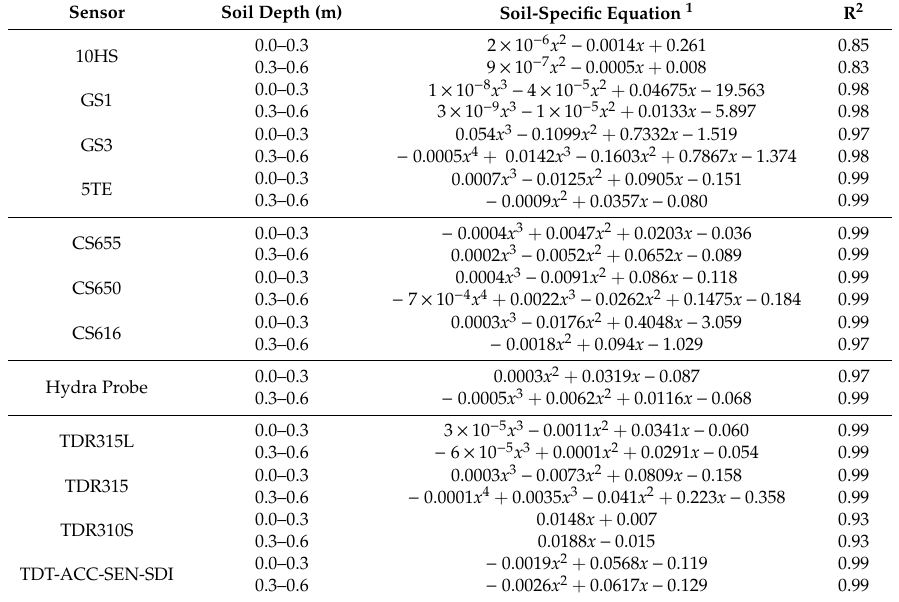
1 Variable corresponds to the response value of the sensor (voltage, period, or dielectric constant). The obtained result from each equation is the soil volumetric water content ( θ v ). Measuring technique: Frequency Domain Reflectometry—FDR (10HS, GS1, GS3, and 5TE); Transmission Line Oscillation—TLO (CS655, CS650, and CS616); Time Domain Reflectometry—TDR (Hydra Probe, TDR − 315L, TDR − 315, and TDR − 310S); and Time Domain Transmissometry—TDT